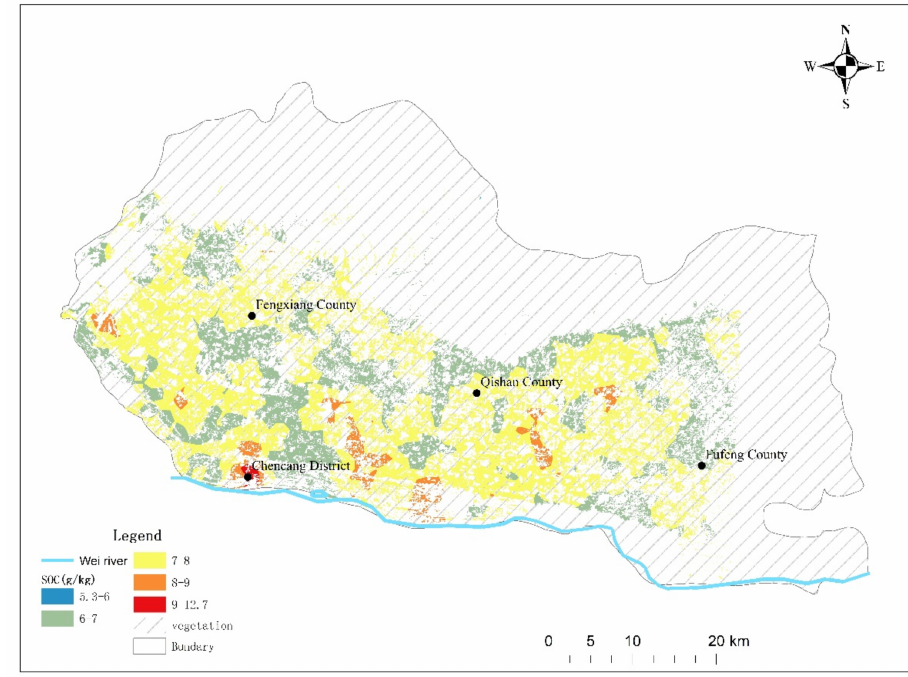
Figure 8. Predicted soil organic carbon (SOC) spatial distribution in the western Guanzhong Plain, China, based on the random forest